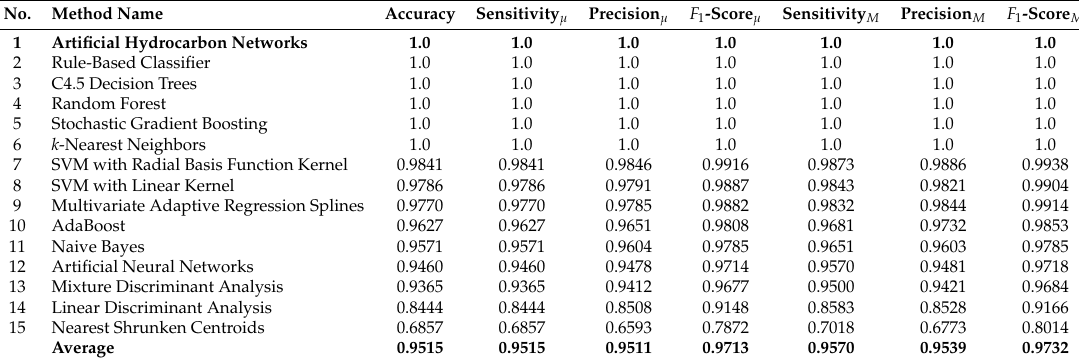
Table 13. Comparison of the supervised classifiers using a majority voting across windows-based approach (2.5-s window